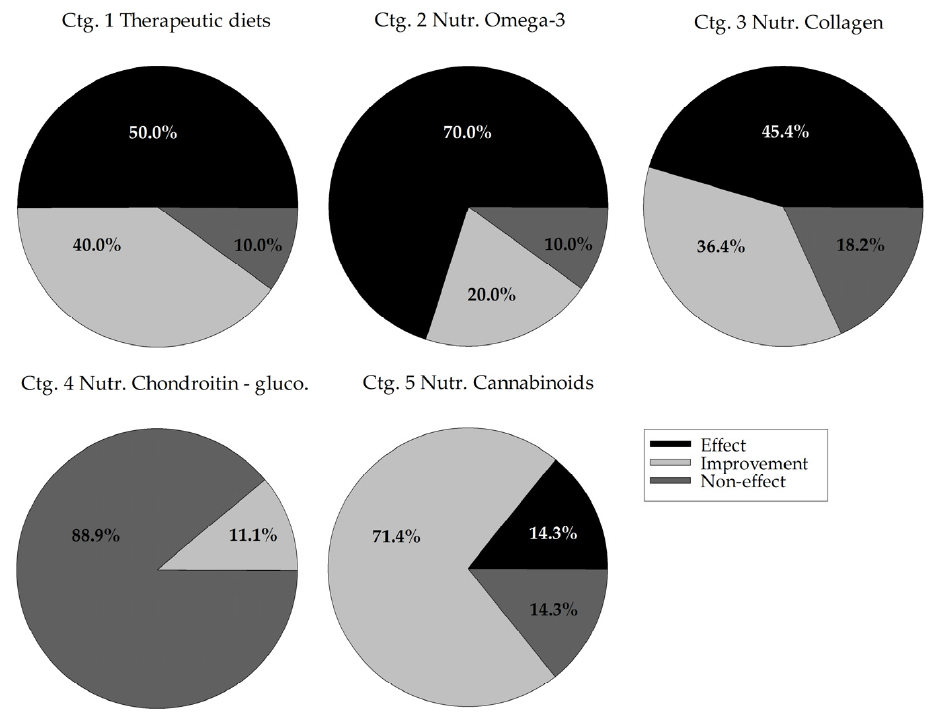
Figure 3. Distribution of efficacy levels of compound categories 1 to 5. On the total number of trials included in each category, expressed are the percentages of trials classified as an analgesic effect (vs. a control group), an improvement over time of the treatment group or a non-effect of the treatment. Ctg. 1 (omega-3-enriched therapeutic diets), ctg. 2 (omega-3-based nutraceuticals), ctg. 3 (collagen-based nutraceuticals), ctg. 4 (chondroitin-glucosamine-based nutraceuticals) and ctg. 5 (cannabinoid-based nutraceuticals). Ctg.,